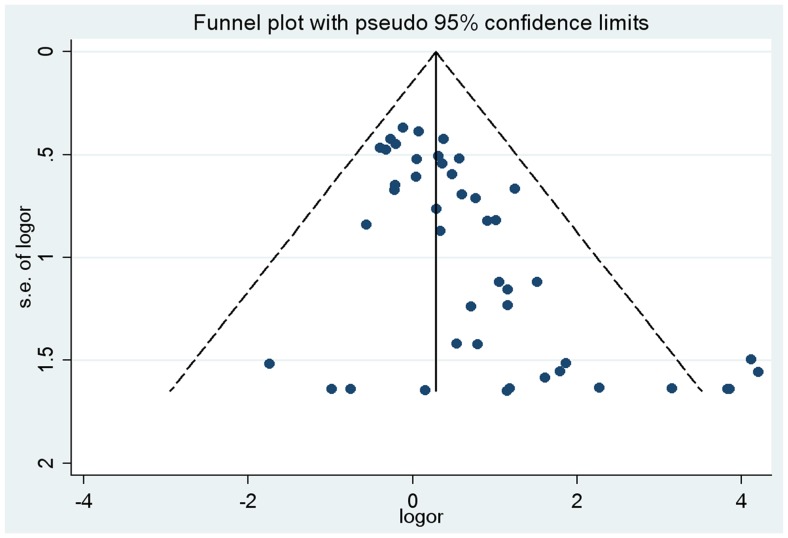
Funnel plot analysis (recessive model of TGFBR1*6A polymorphism) to detect publication bias.Each point represents an individual study for the indicated association. LogOR, natural logarithm of OR. Perpendicular line, mean effect size.